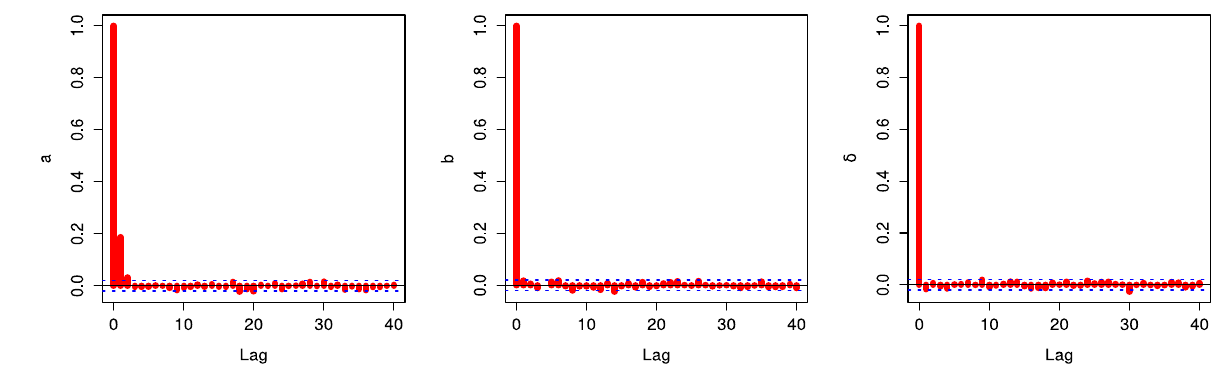
Figure 14. The ACF plot of MCMC results for Saudi Arabia data set.